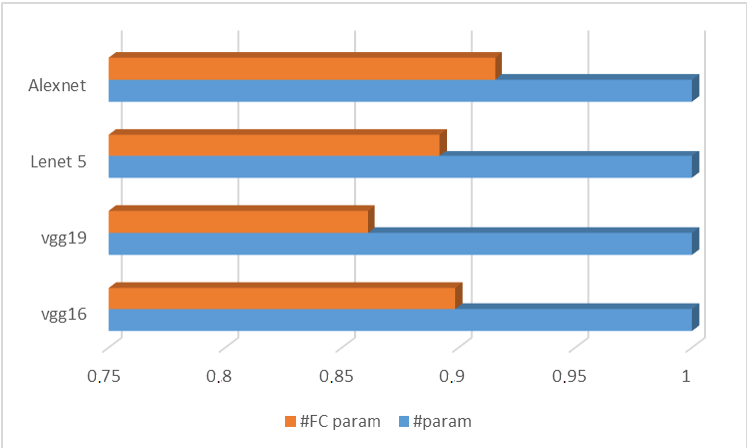
Figure 1. Ratio of the number of FC parameters to the total number of parameters in some well-known CNN